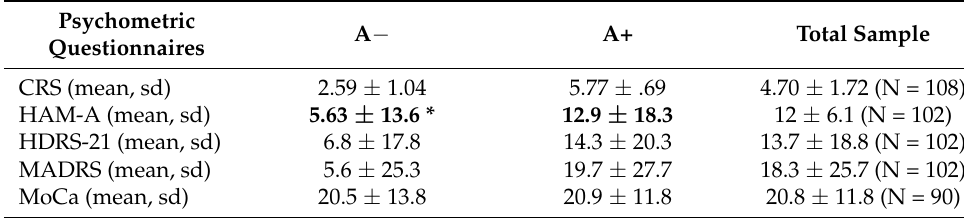
Table 2. Comparison of psychometric questionnaires between subgroups.